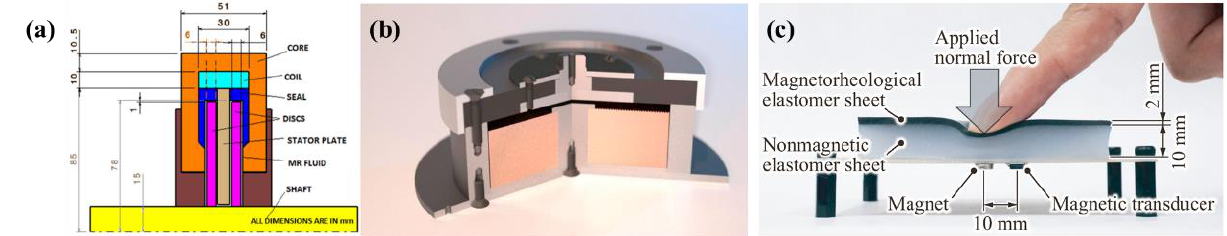
Figure 10. Applications of ( a ) a finite element analysis model of a proposed MR brake (Patil et al. [96], ©Elsevier Ltd., 2016), ( b ) a sectional view of an active damper based on an MR elastomer (Mikhailov et al. [103], ©Elsevier B.V., 2016), and ( c ) the basic structure of a flexible tactile sensor (Kawasetsu et al. [108], ©MDPI,